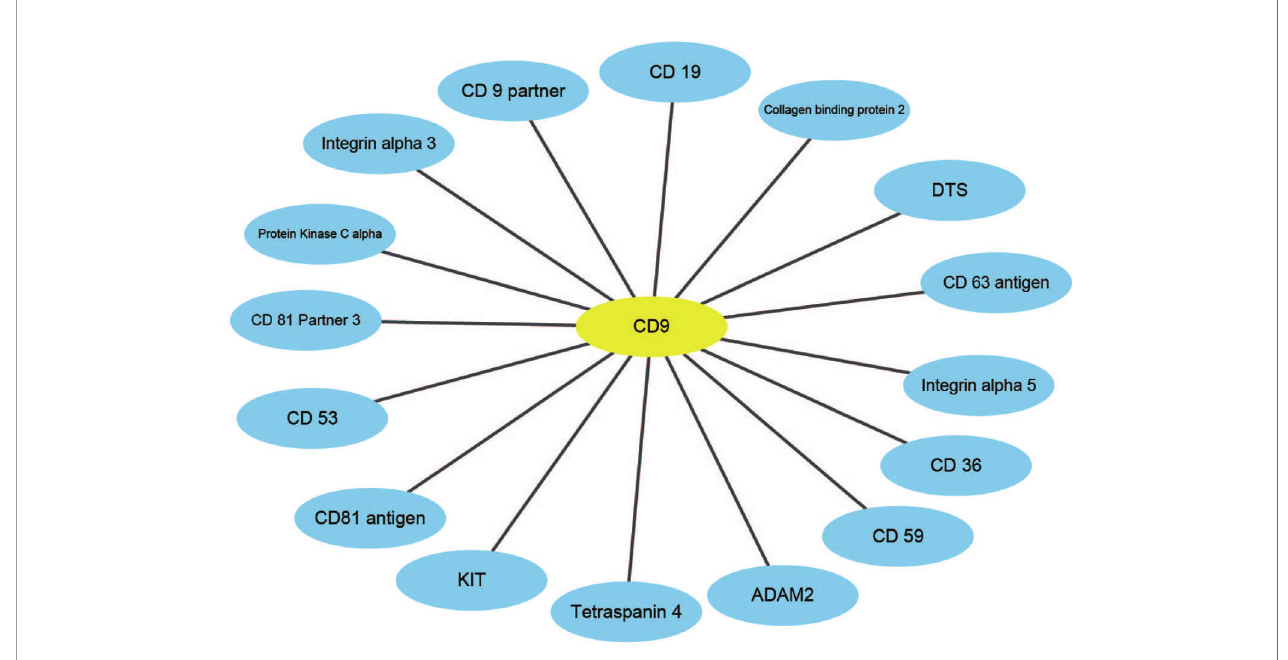
FIGURE 6 | The prediction results of single-core network of CD9.